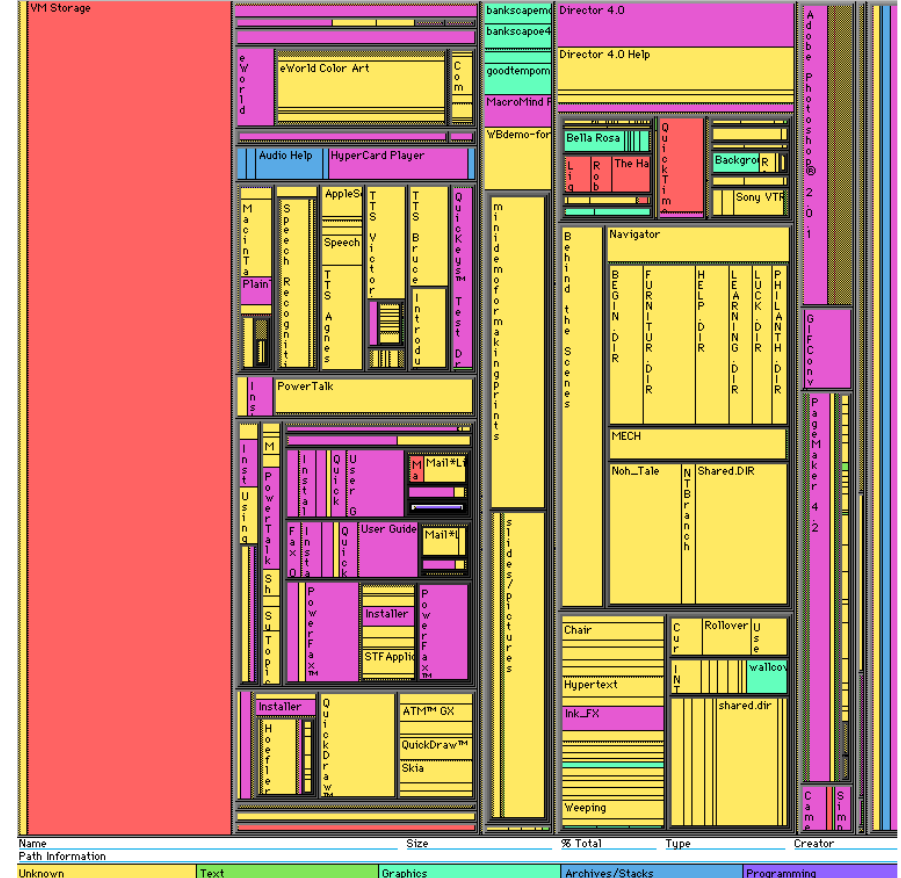
Figure 6. The tree shown in Figure 5 but redrawn using squarified treemaps [43]. It is noticeable that the desire for the equilateralness of rectangles gives rise to the complexity of determining hier- archical nesting.